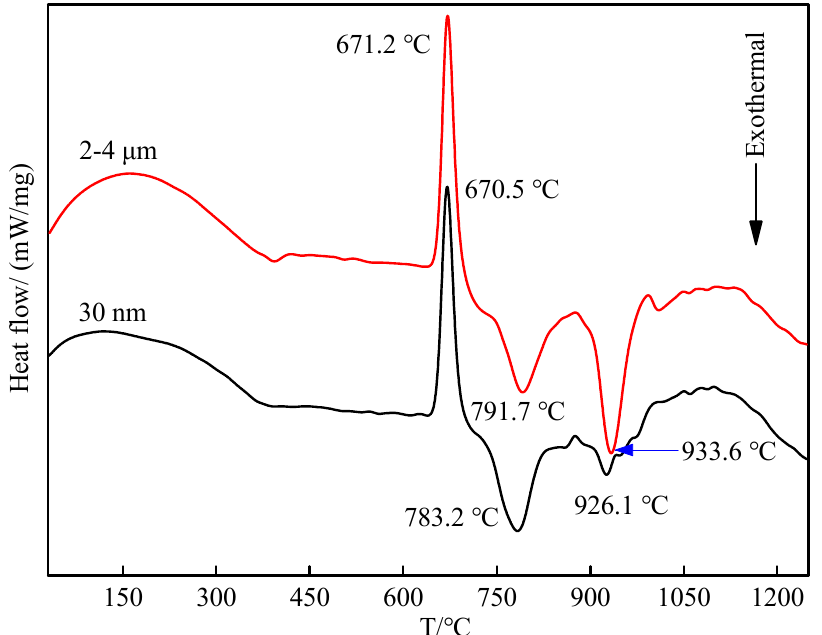
Figure 11. DSC curves of Al-Ti-C-Ce with different CeO 2 size of: 30 nm and 2–4 μ m.